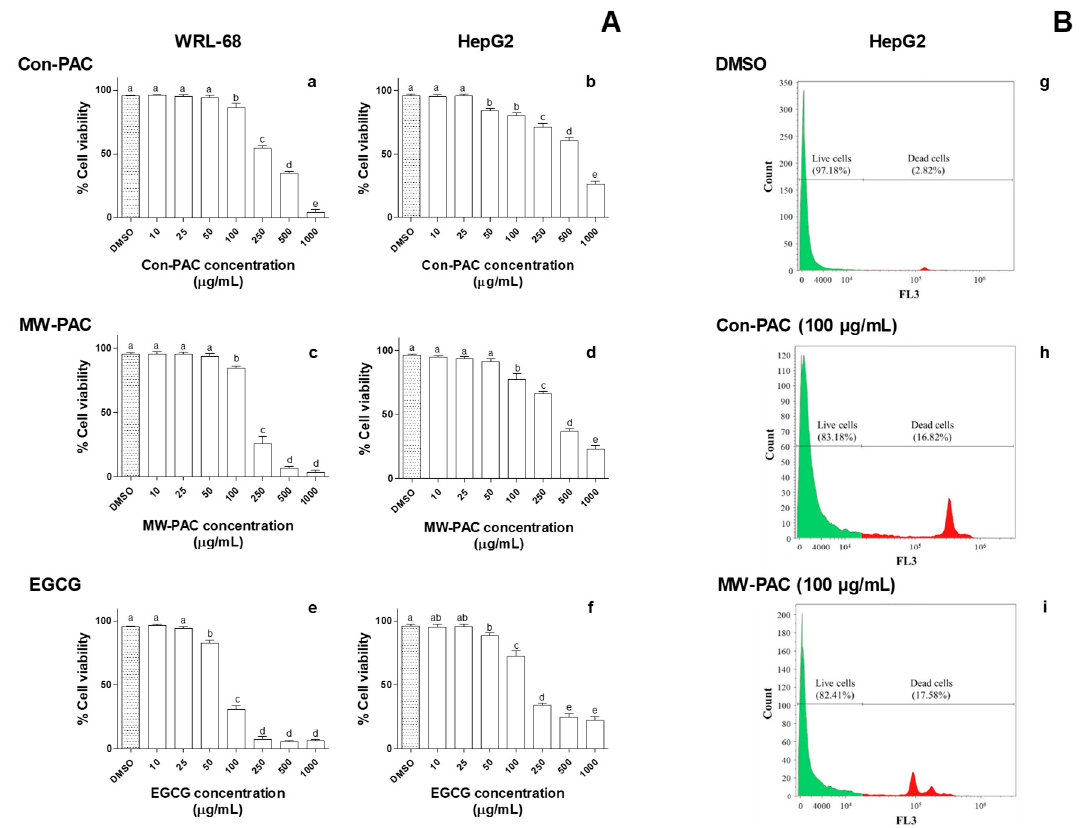
Figure 6. Cell viability (%) of WRL-68 and HepG2 cells exposed to di ff erent concentrations of Con-PAC, MW-PAC, and EGCG measured by 7-AAD-stained flow cytometry ( A ) and FL3 histograms of the HepG2 cells ( B ) treated with 100 µ g / mL of PAC. WRL-68 and HepG2 cells were exposed to 10–1000 µ g / mL concentrations of Con-PAC, MW-PAC, and EGCG for 24 h. Cells were stained with 7-AAD stain in the dark (5 min) and analyzed by flow cytometry under the FL-3 filter. FACS data were processed by Kaluza Analysis (version 2.1) flow cytometry analysis software. Results presented are means ± SD of three independent experiments. Means sharing the same letter are not significantly di ff erent at the 5% level. PACs: proanthocyanidins; Con-PAC: proanthocyanidins extracted by the conventional method; MW-PAC: proanthocyanidins extracted by microwave-assisted method; EGCG, epigallocatechin gallate.